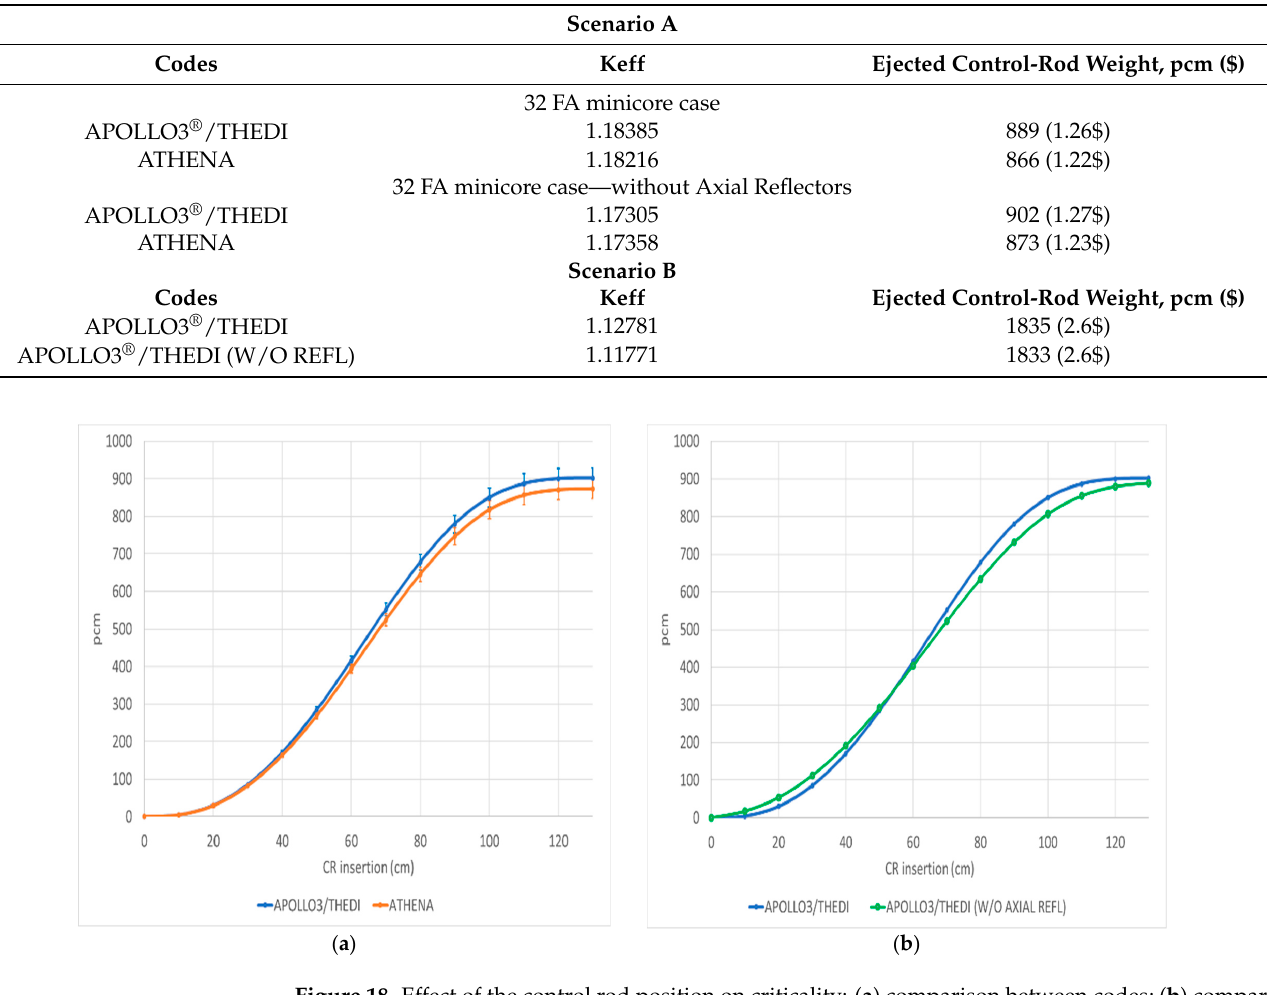
Figure 18. Effect of the control rod position on criticality: ( a ) comparison between codes; ( b ) compari- son between